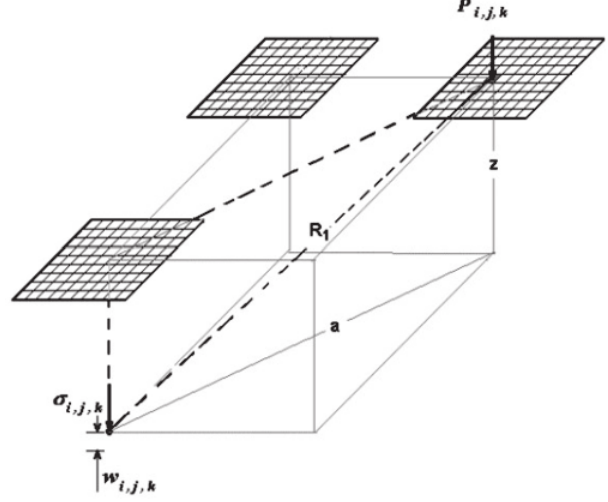
Modelo de ISE (Fonte: Reis,